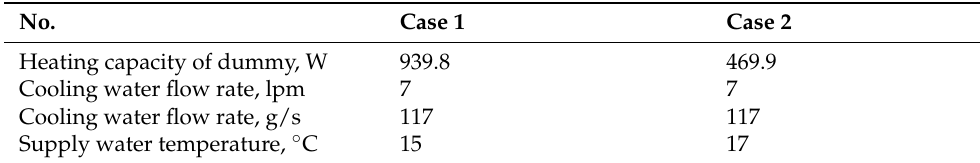
Table A2. Case design of experiments for model validation